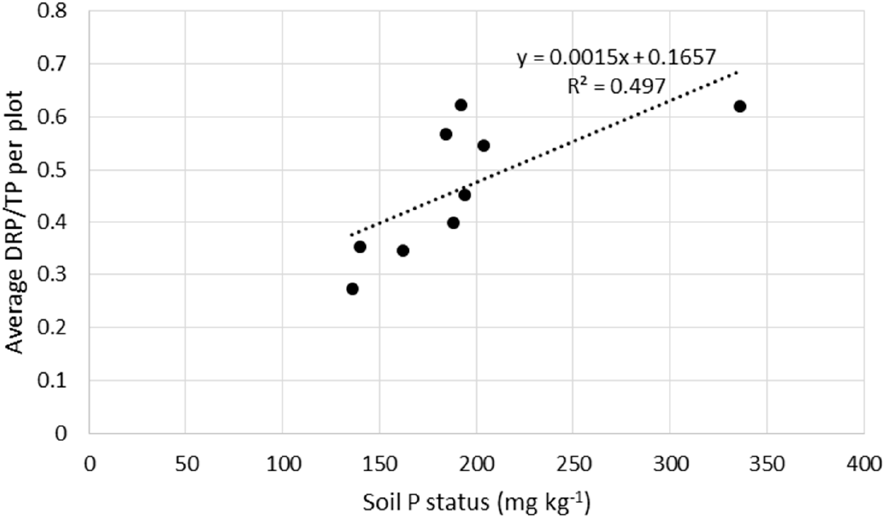
Figure 5. Average dissolved reactive phosphorus (DRP)/total phosphorus (TP) in surface runoff all years per plot in relation to soil P status (mg P-AL kg − 1 ).